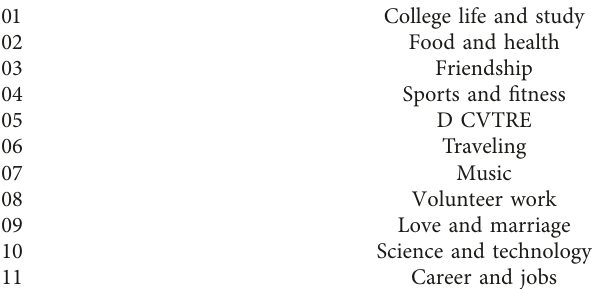
Table 6: Teaching units